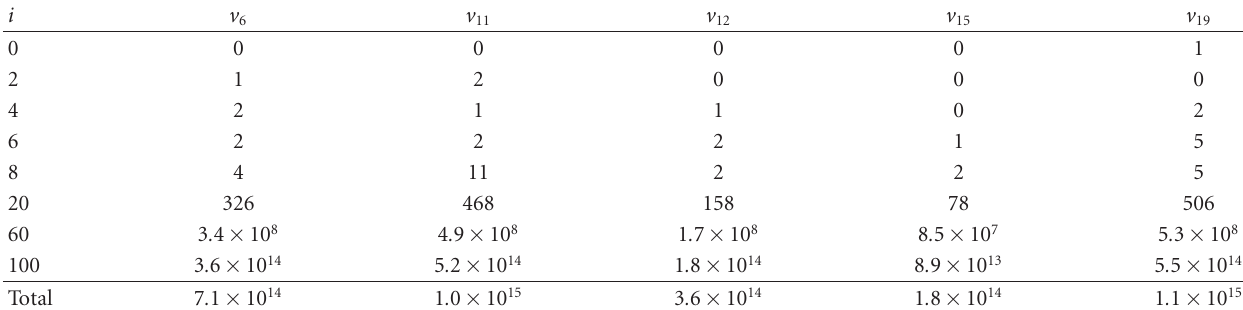
Table 4: The multiplicity of variable nodes contained in the deviation created using the directed graph given in Figure